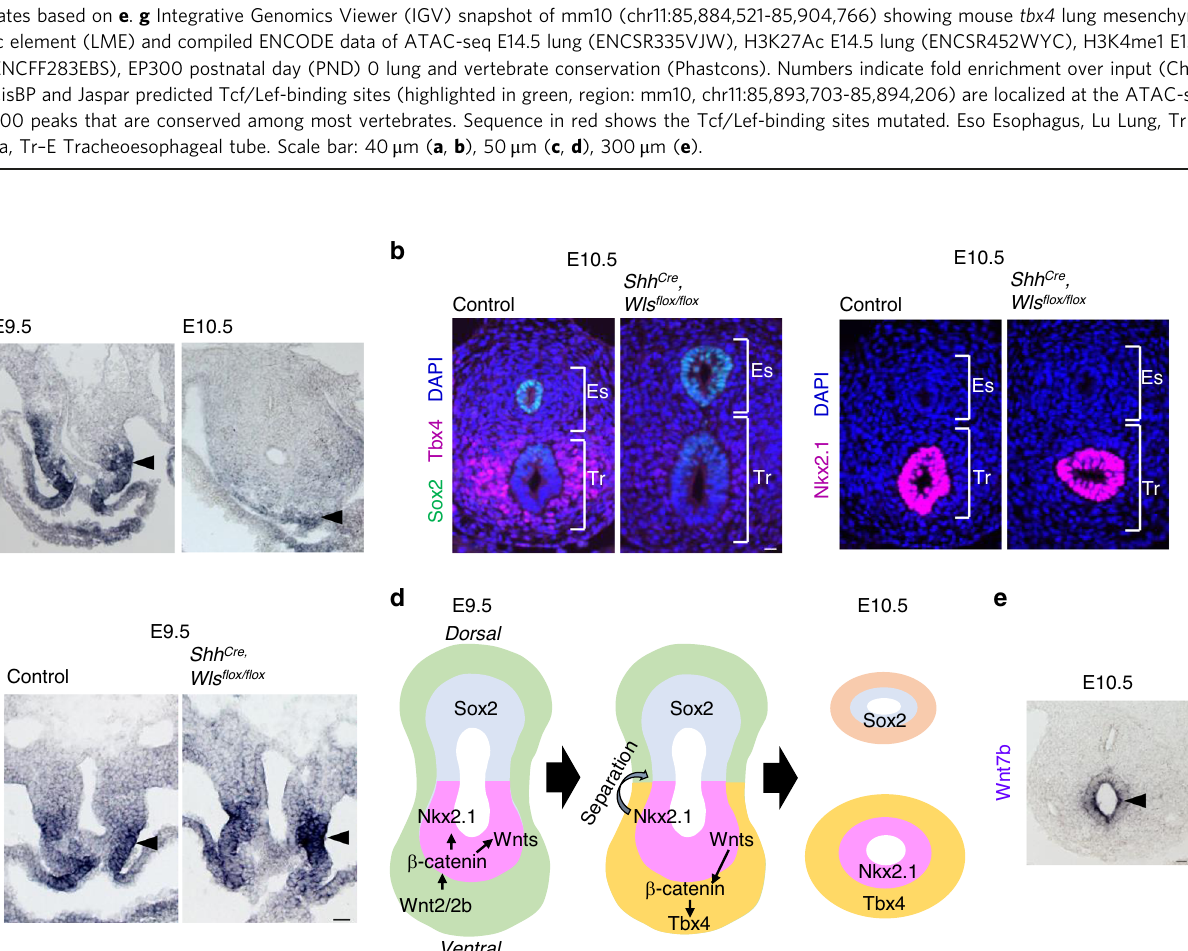
Fig. 3 Endodermal Wnt ligands induce Tbx4 expression for tracheal mesoderm development of mouse trachea. a In situ hybridization for Wnt2 mRNA during tracheoesophageal segregation. Arrowheads indicate Wnt2 expression in the ventrolateral mesoderm at E9.5 and E10.5. n = 2/2 embryos. b Transverse sections of Shh Cre , Wls fl ox/ fl ox mouse embryos and littermate controls at E10.5. Left panels show sections stained with Sox2 ( green ), Tbx4 ( magenta ), and DAPI ( blue ). Right panels show sections stained for Nkx2.1 ( magenta ) and DAPI ( blue ). n = 3/3 embryos per genotype. c In situ hybridization for Wnt2 mRNA in Shh Cre , Wls fl ox/ fl ox mouse embryos and littermate controls at E9.5. Arrowheads indicate Wnt2 expression in the ventrolateral mesoderm. n = 2/2 embryos. d Re fi ned model of tracheoesophageal segregation and tracheal mesodermal differentiation. e In situ hybridization for Wnt7b mRNA in mouse embryo at E10.5. Arrowhead indicates Wnt7b + cells. n = 2/2 embryos. Eso Esophagus, Lu Lung, Tr Trachea. Scale bar; 40 μ m ( a – c ), 50 μ m ( e